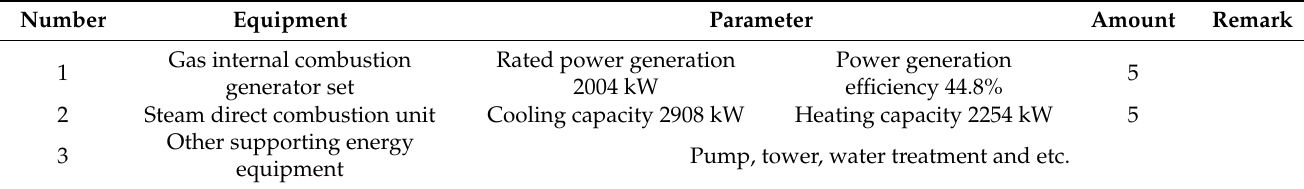
Table A2. Natural gas combined cooling, heating, and power system main